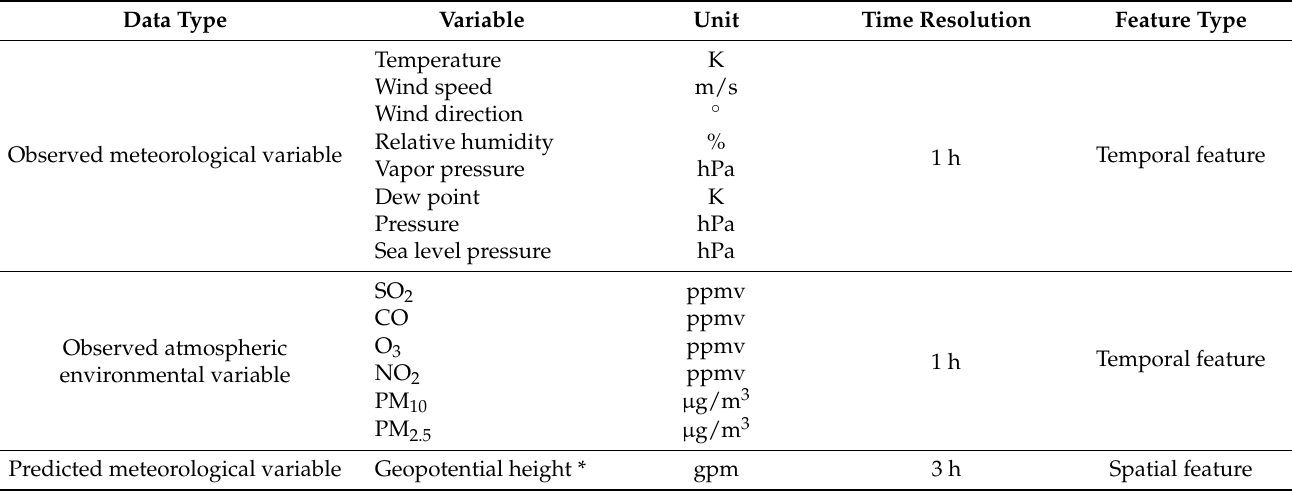
Figure 1. Locations of KMA ASOS and NIER AIR KOREA observation sites in seven major cities: ( a ) Seoul, ( b ) Incheon, ( c ) Daejeon, ( d ) Gwangju, ( e ) Daegu, ( f ) Ulsan, and ( g ) Busan. The blue circle represents the ASOS site, and the red triangle represents the AIR KOREA site. Table 2. Input variables of CNN+LSTM hybrid PM 2.5 prediction model.